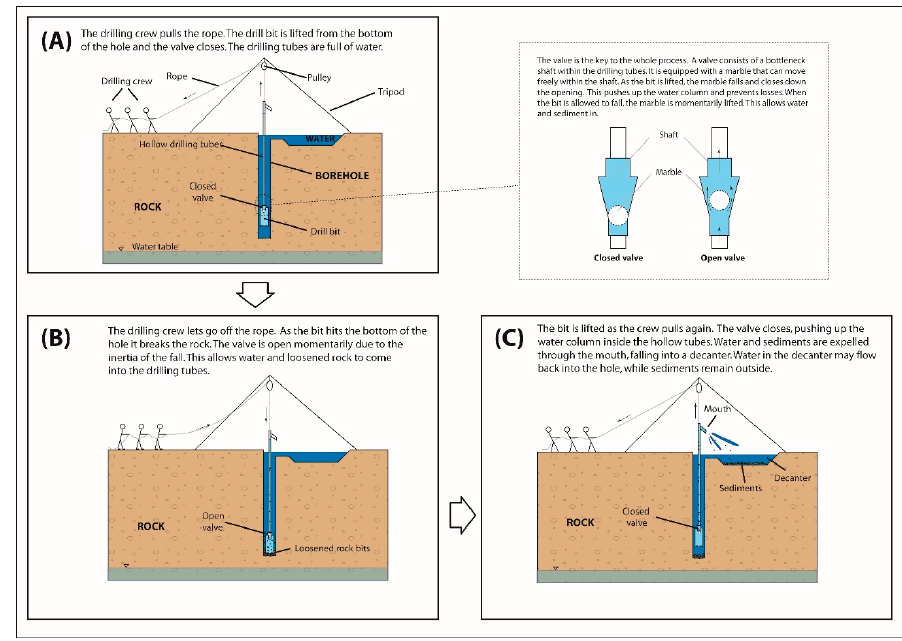
Figure 4. Overview of the drilling method.